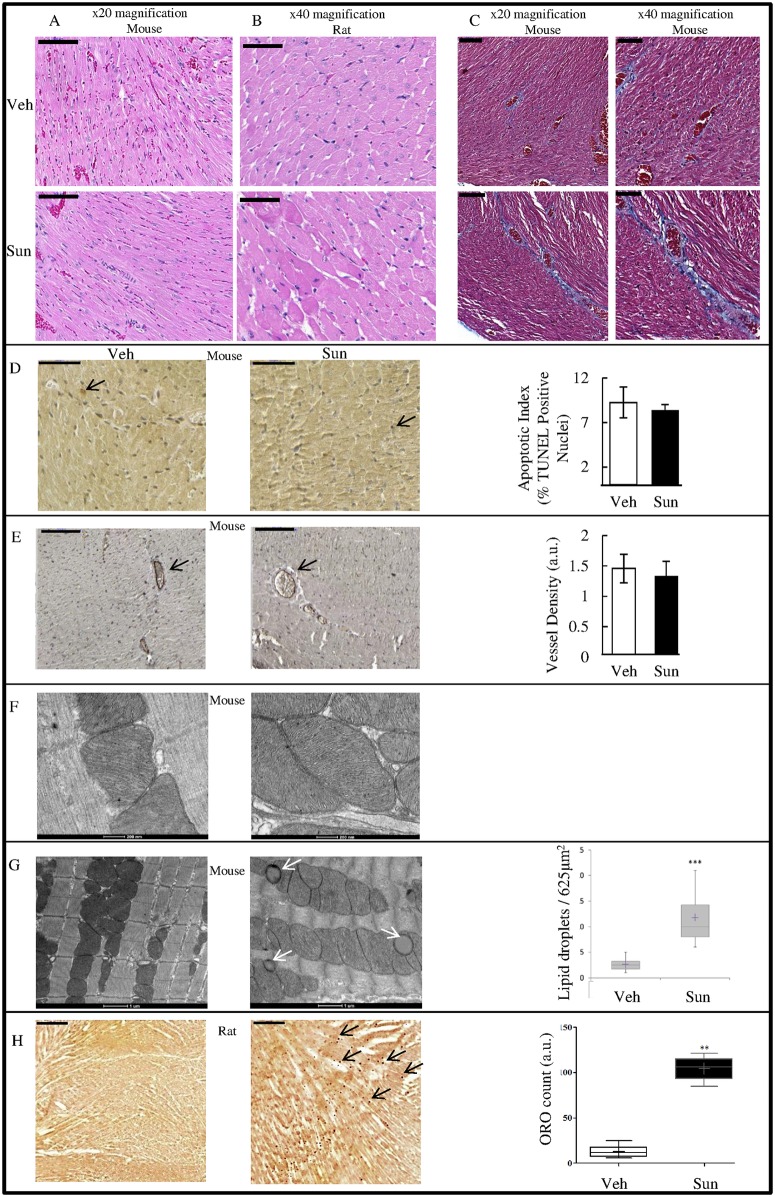
Histopathologic assessment of rodent myocardium following sunitinib treatment.All error bars represent SEM unless otherwise indicated. H&E staining in mice (A) and rats (B) Magnification as indicated, scale bars (black) 100 μM and 50 μM respectively. C) Masson’s trichrome staining to assess fibrosis in the myocardium of vehicle versus sunitinib treated mice (scale bars (black) represent 100 μm (left) and 50 μm (right), magnification as indicated). D) TUNEL staining for the assessment of apoptosis in mice (40 × magnification; scale bar (black): 50μm. 1000 nuclei were counted per organ using ImageJ software. % TUNEL positive nuclei shown). E) Microvessel density in mice (CD31 immuno-staining). Representative images shown; scale bar (black) 50 μm, x 40 magnification. Vascular density is expressed as % CD31 positive pixels to total pixels captured in each image. F and G) EM analysis of cardiac tissue (mice) to determine the presence of mitochondrial damage [high magnification; x 29000] (F) and the presence of lipid droplets (white arrows) [lower magnification; ×11500] (G), scale bars as indicated ** p = <0.01, n = 4/group. H) ORO analysis in rat heart cryosections to determine lipid droplet accumulation (black arrows indicate representative red lipid droplets, scale bars represent 500 μm; magnification is ×5; n = 3/group. Quantification a.u, arbitrary units **p < 0.01, compared with vehicle. Values are means ± SD).